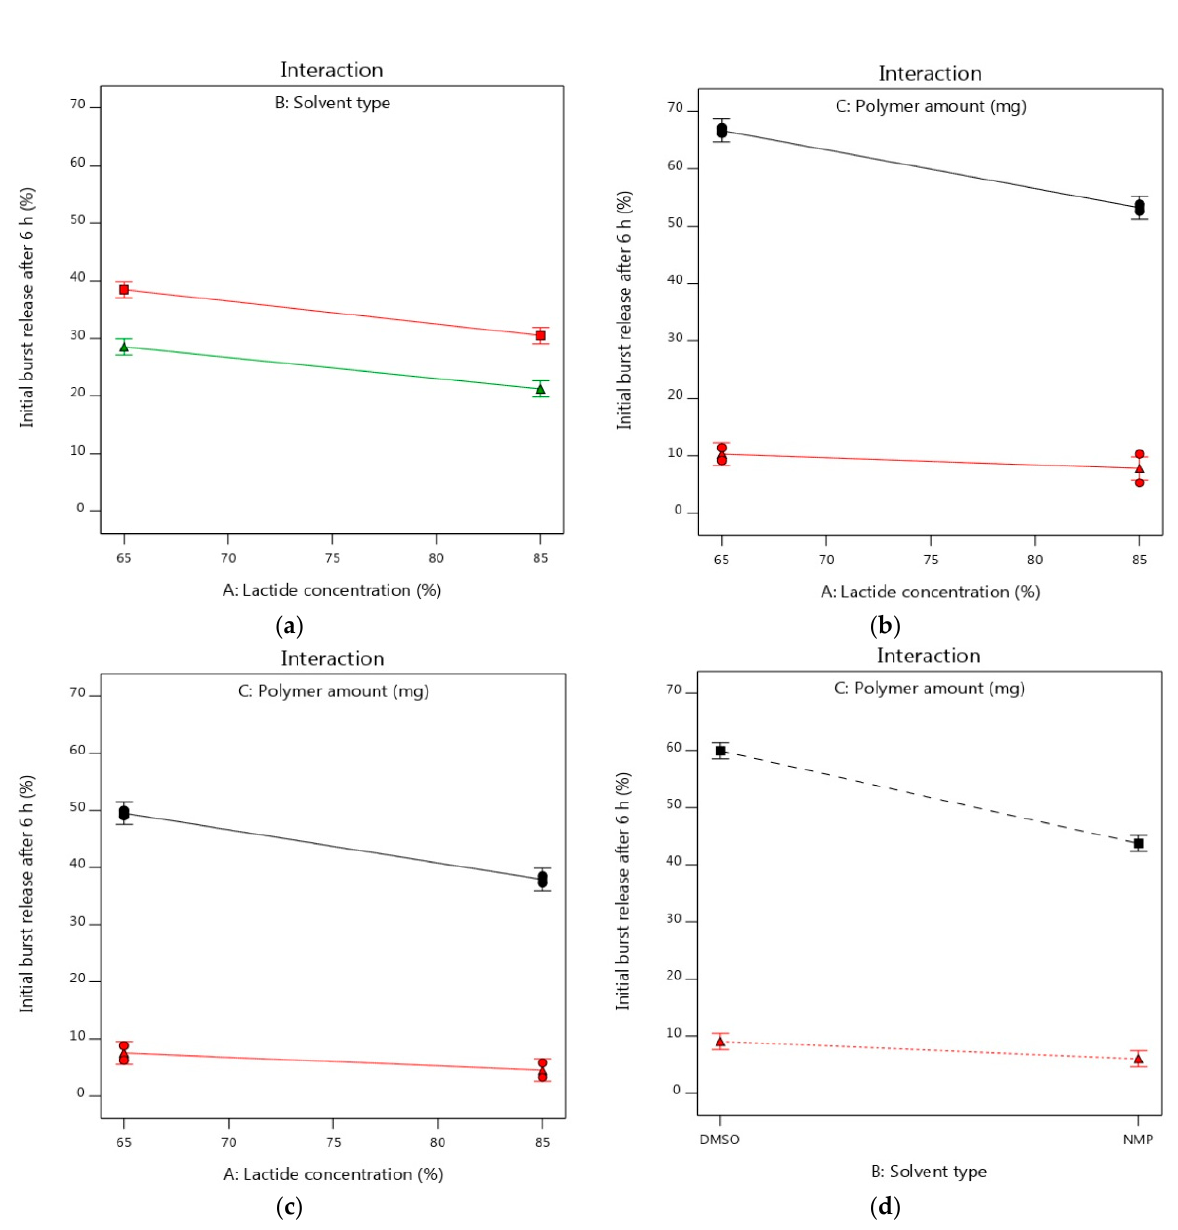
Figure 4. Interaction plots of influence of independent factors on Y 1 response ( a ) effects of A and B ( b ) effects A and C using DMSO ( c ) effects of A and C using NMP ( d ) effects of B and C. Figure 4a: the upper line refers to DMSO and the lower line refers to NMP. Figure 4b,c,d: the upper black lines refer to PLGA (187.5 mg) and the lower red lines refer to PLGA (312.5 mg).